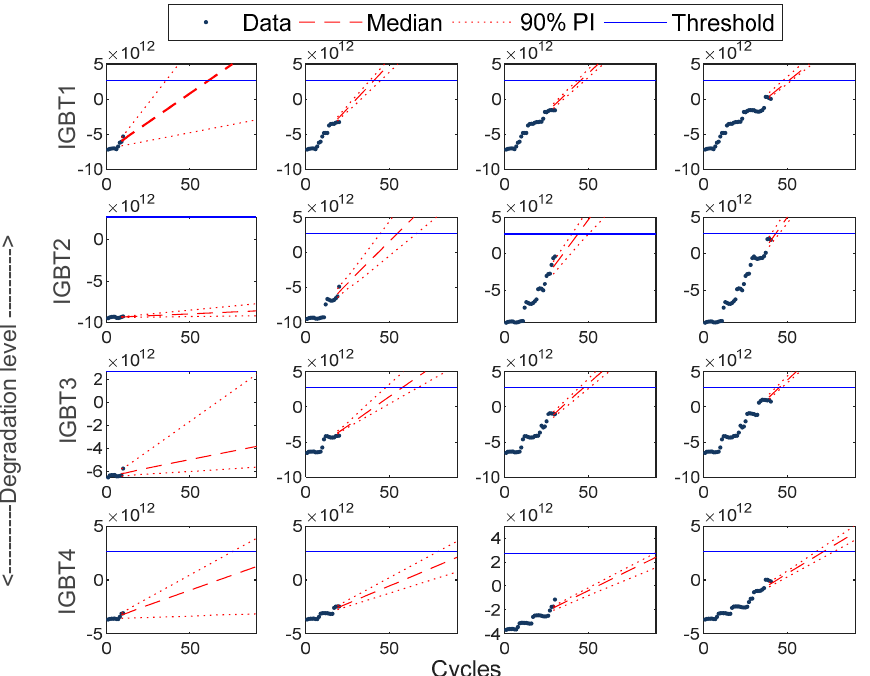
Figure 10. Prediction of degradation level with a different number of data points.